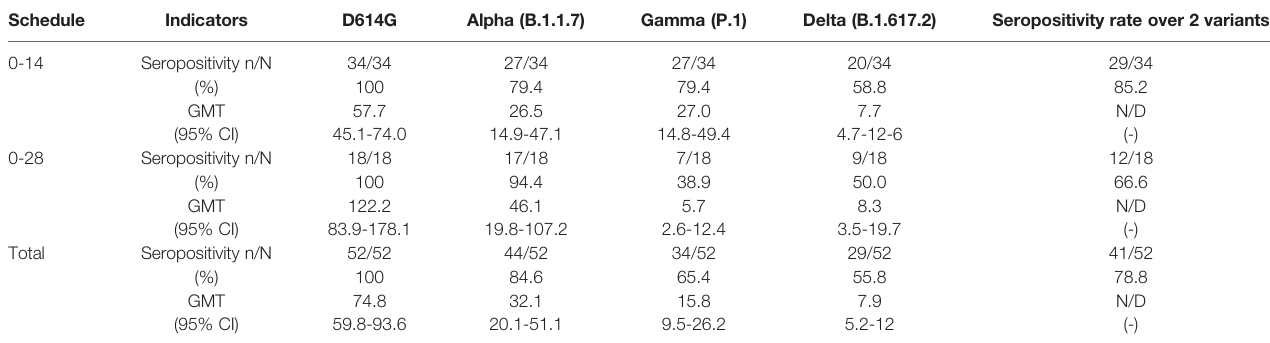
TABLE 2 | Seropositivity rates and geometric mean titer of neutralizing antibodies against SARS-CoV2 variants by cVNT.